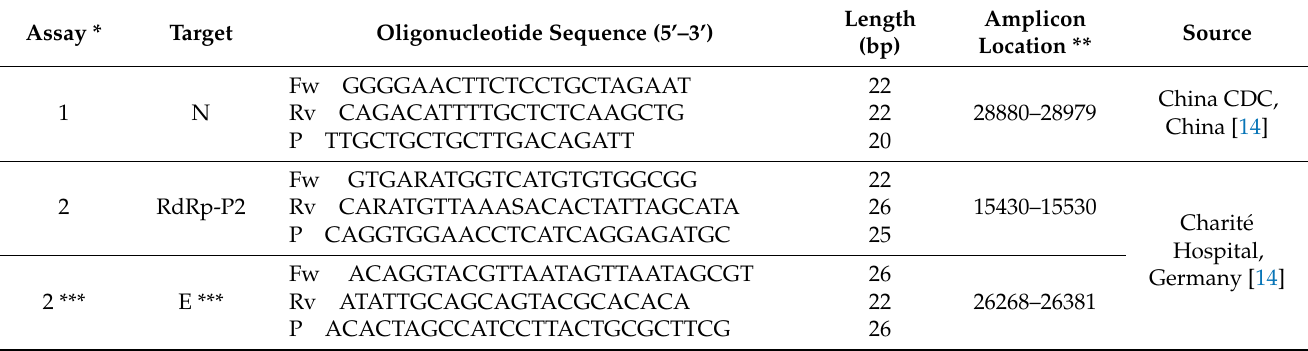
Table 1. List of investigated primers and probe